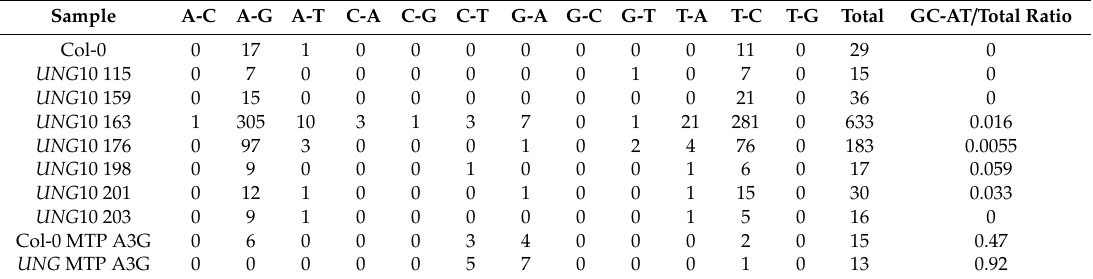
Table 1. Heteroplasmic mitochondrial single nucleotide polymorphisms (SNPs) in Col-0